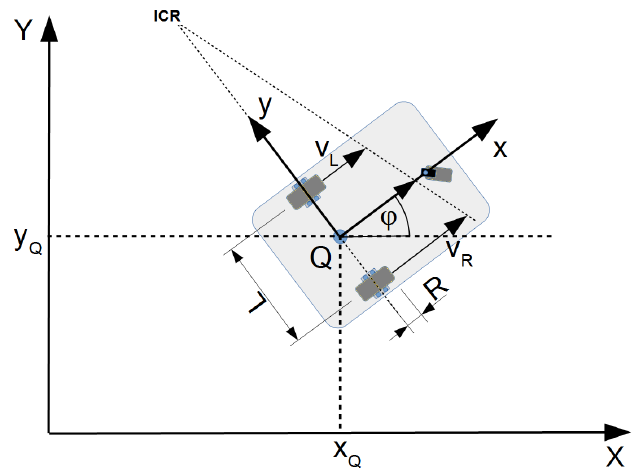
Figure 7. Parameters of the mobile robot.